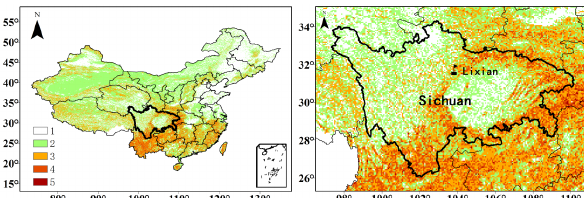
Figure 2. Landslide susceptibility in China and in Guizhou province